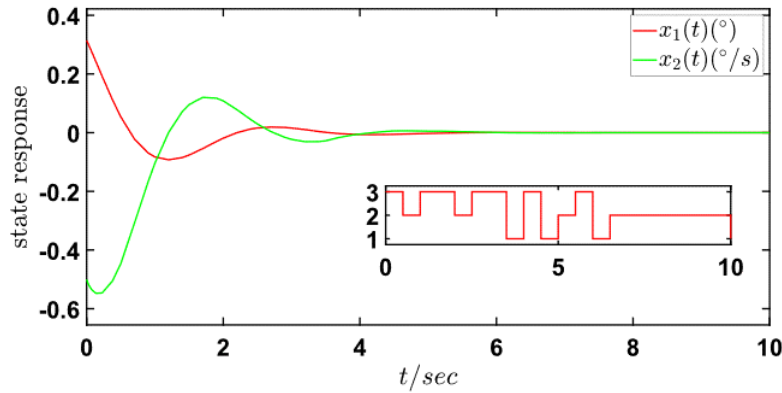
Figure 2. The state response of original system.